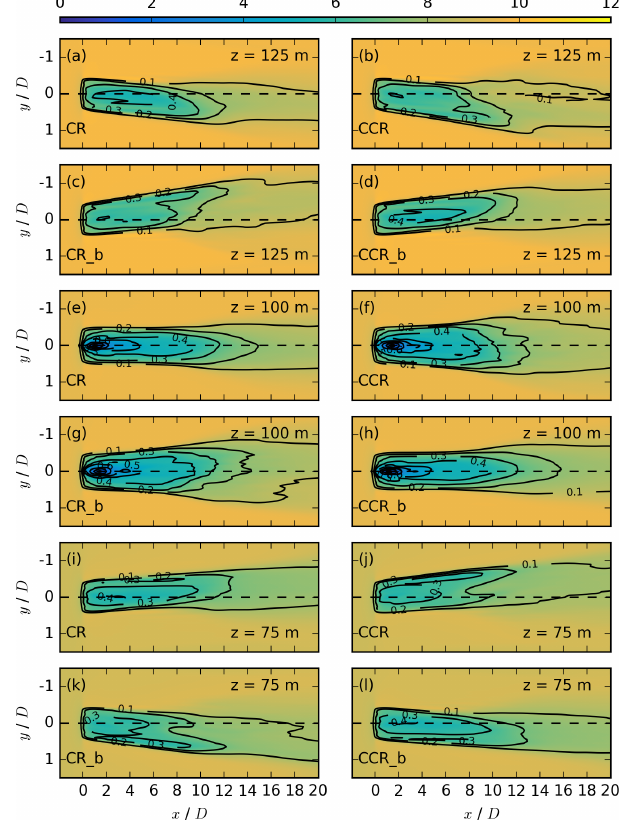
in meters per ∗ at the same vertical ∗